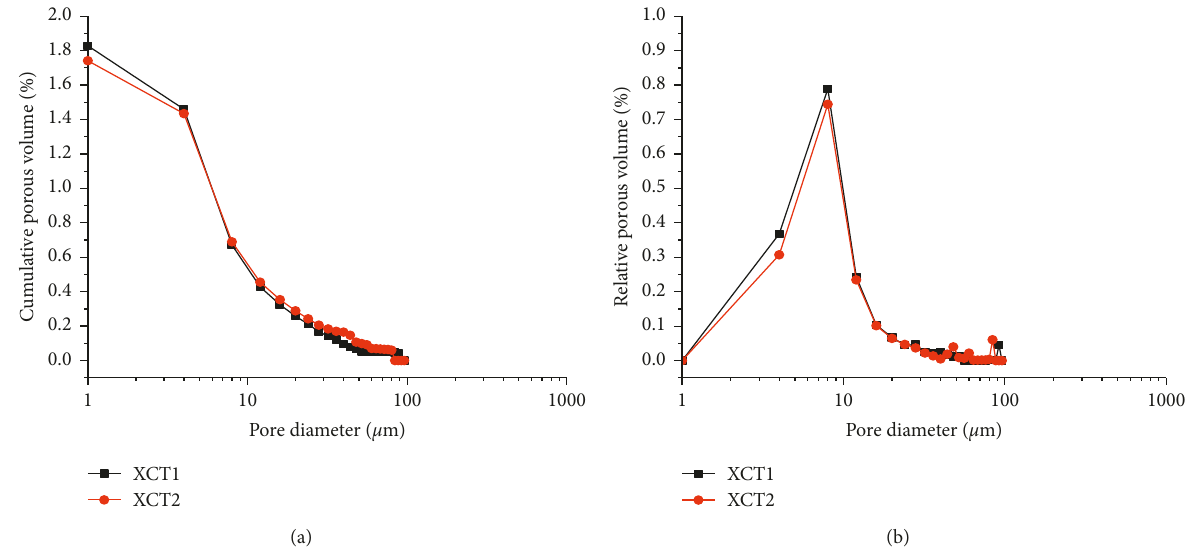
Figure 10: Pore size distribution of hardened cement paste by XCT: (a) cumulative curve; (b) relative